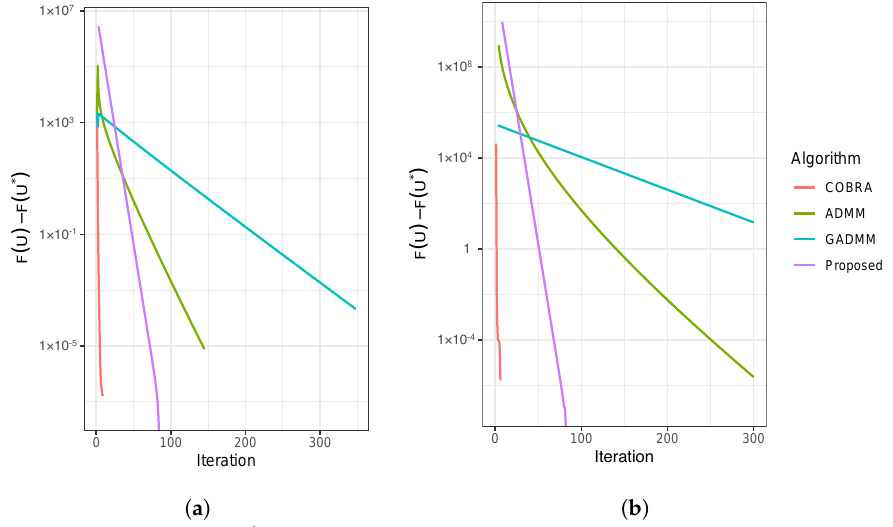
Figure 6. Plot of log ( F ( U k ) − F ( U ∗ )) vs. the number of iterations. ( a ) TCGA; ( b )